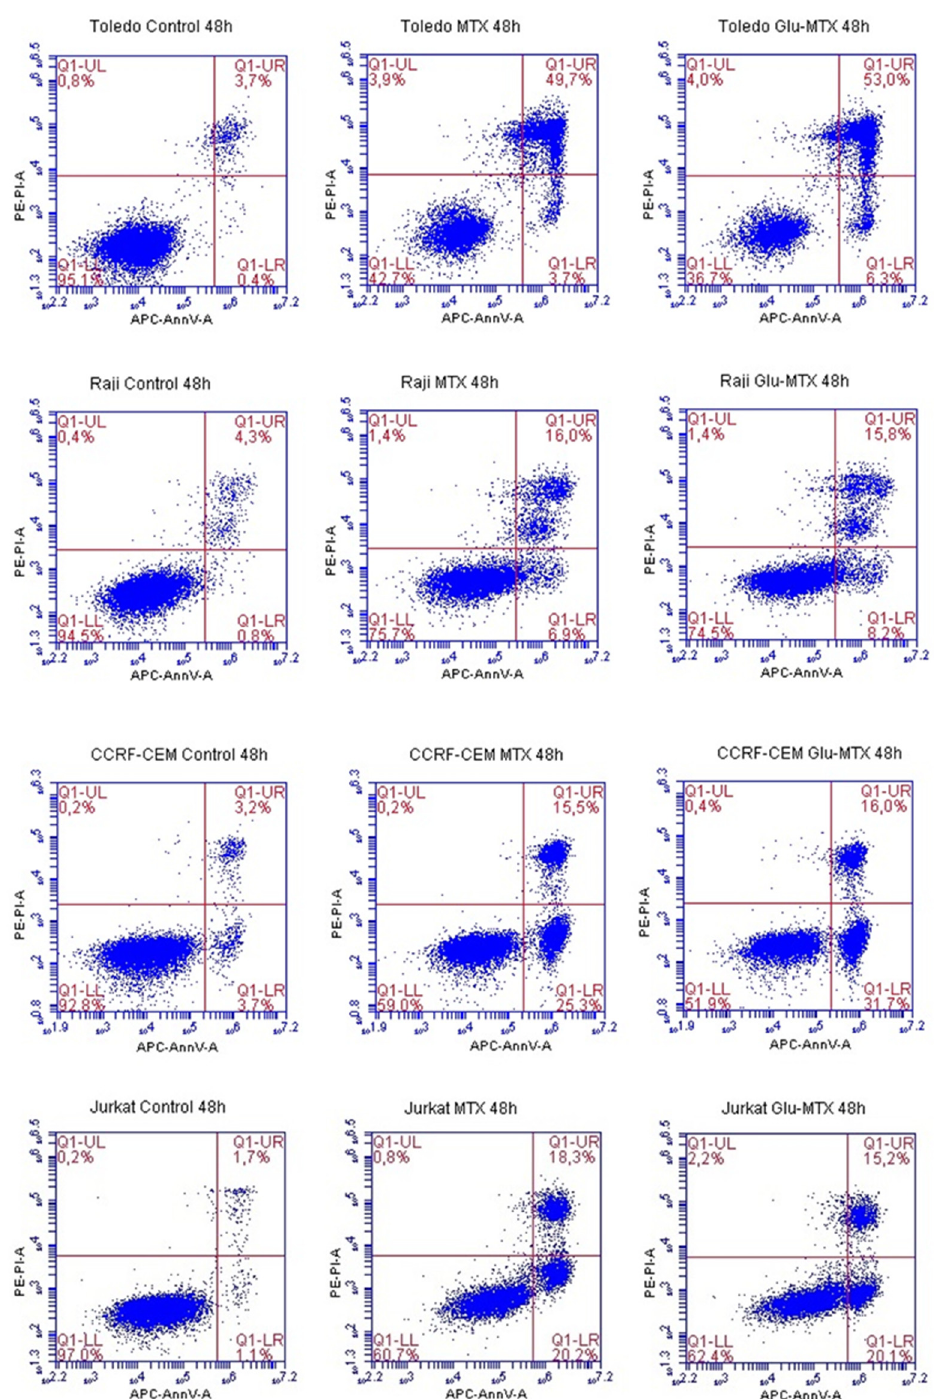
Figure 4. Representative images of flow cytometry analysis of alive (LL, lower left), early apoptotic (LR, lower right), late apoptotic (UR, upper right), and dead (UL, upper left) Toledo, Raji, CCRF–CEM, and Jurkat cells after incubation with 0.1 µM of MTX and Glu–MTX for 48 h.